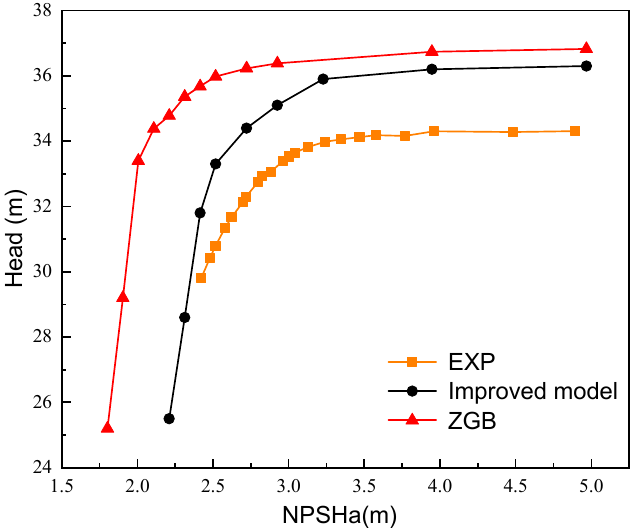
Figure 4. Comparison of cavitation performance curves.